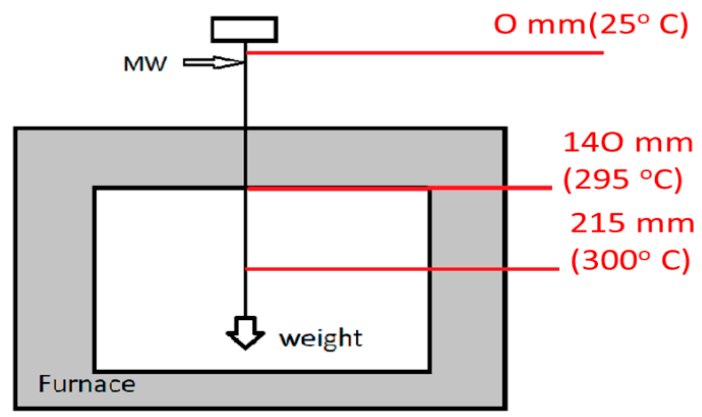
Figure 2. Scheme of stress-annealing at variable temperatures.